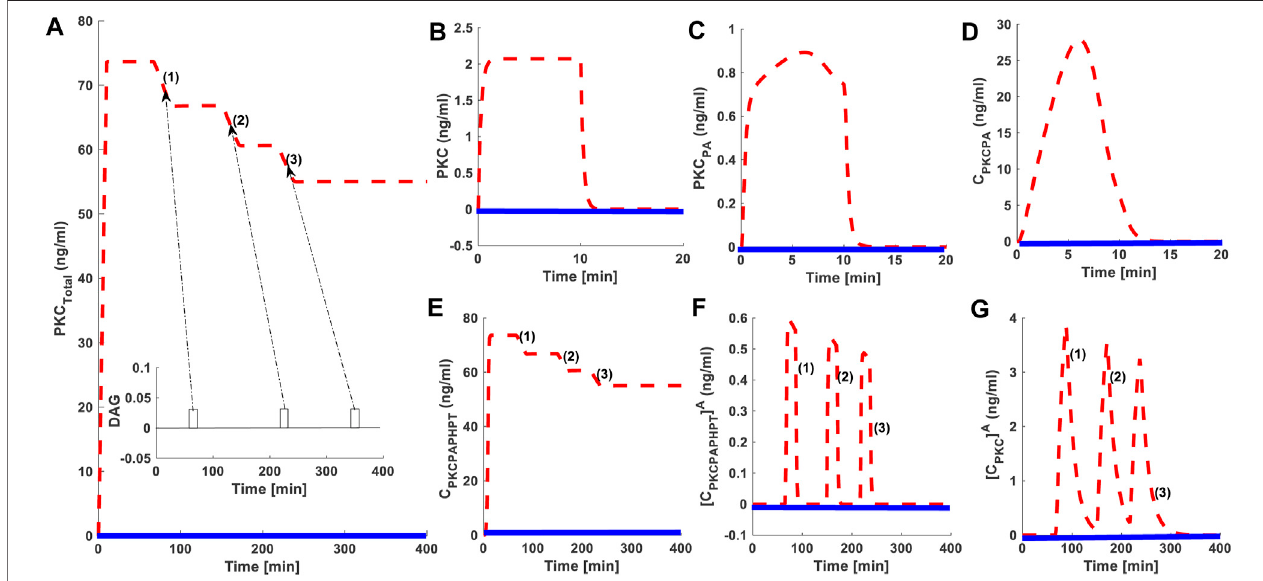
FIGURE 5 | The effect of sequential application of second messenger stimulation on the down-regulation characteristics of the cPKCs. Here, dashed red lines represents the stimulation whereas, the solid blue line represents non-stimulated conditions. Here, three equal pulses of second messenger are applied in a sequential manner. Thepulse 1isapplied at t= 50 min; the pulse 2 isapplied at t=220 min; and the pulse 3is applied at t =360 min. Forall these three pulses second messenger levelsaresetatDAG=0.005 nM;Theseresultsshowthesecondmessenger-induceddestabilizationanddown-regulationofcPKCs.Theseresultsalsoshowthat with application of each pulse, a certain amount of enzyme is downregulated, and total PKC levels are stabilized at new levels. These results indicate that during simulationsthreedown-regulationeventsareobservedeachinresponsetoasecondmessengerpulseatt=50 min;t=220 min;andt=360 min. (A) TotalPKCenzyme during protein synthesis and second messenger mediated stimulation. (B) The concentration of naïve, newly synthesized unstable form of cPKC. (C) The concentration of PKC species phosphorylated at activation site. (D) The concentration of PKC complex C.PKC.P A . (E) The concentration of PKC complex, phosphorylated at all three sites i.e., activation, turn and hydrophobic sites. (F) The concentration of active complex PKC. P A .P H .P TA after second messenger binding. (G) Concentration of dephosphorylated but active PKC A